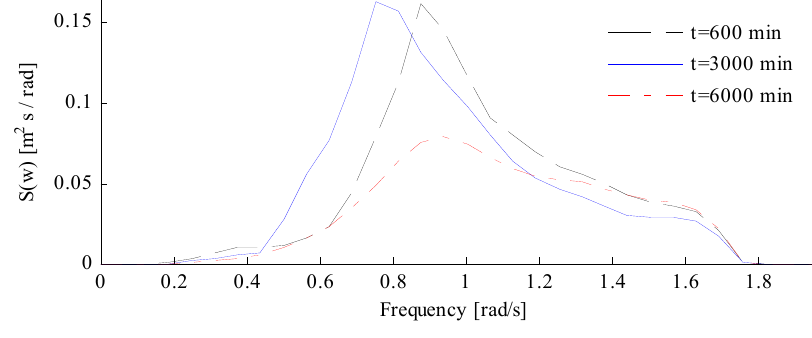
Figure 5. Spectra measured per minute by X-band radar.